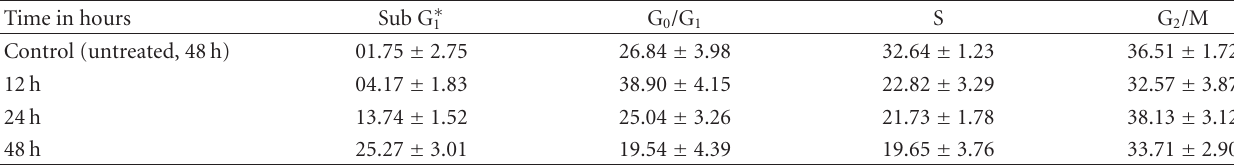
Data represents mean ± S.D; ∗ means are significant at P < 0 .